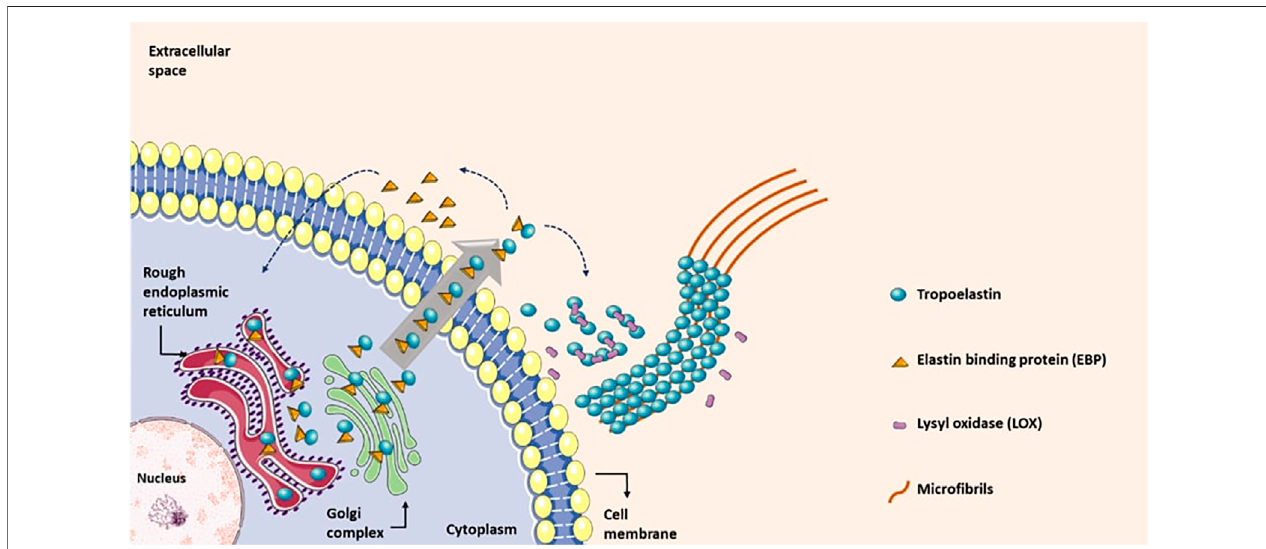
FIGURE2 | Elastin biosynthesis:after synthesis in therough endoplasmic reticulum (rER), thetropoelastin-EBP complex istransported through theGolgi complex to the extracellular space, aggregating on the cell surface. EBP then unbinds from tropoelastin, and tropoelastin molecules are cross-linked to each other via lysine residues that are oxidized by lysyl oxidase (LOX) generating cross-linked elastin. The cross-linked molecules deposit onto micro fi brils which direct elastin deposition for the formation of the elastic fi bers. EBP is then recycled back into the cell and binds newly synthesized tropoelastin molecules. This process continues, producing insoluble elastin fi bres.